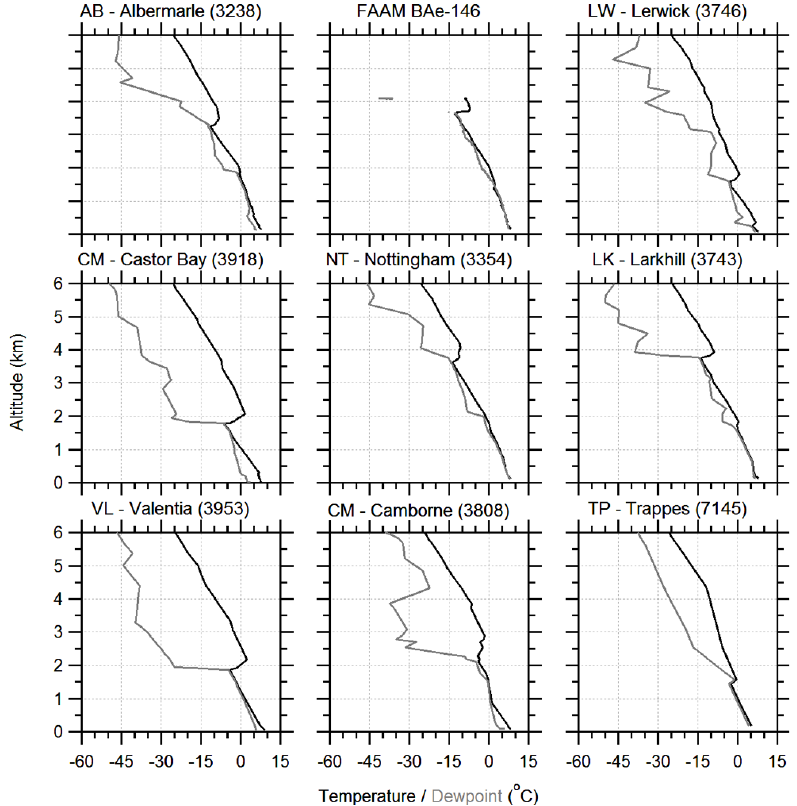
Fig. 3. Profiles of temperature (black) and dewpoint (grey) from radiosonde station soundings at 12:00 UTC and the FAAM aircraft profile (11:42–11:57 UTC). Radiosonde station locations are highlighted in Fig. 2.